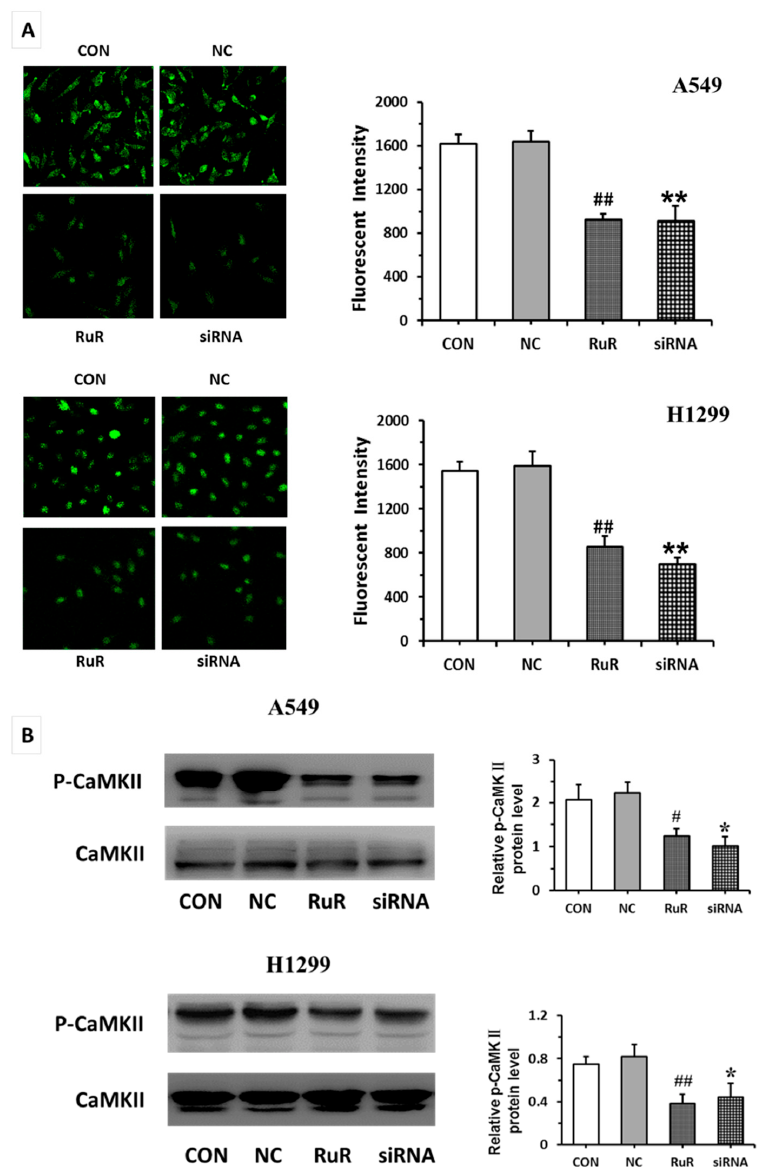
Figure 4. Measurement of [Ca 2+ ] i in A549 and H1299 cells. Fluorescent intensity in [Ca 2+ ] i was recorded by laser scanning confocal microscope in different treatments (400×) ( A ); Western blot assay for p-CaMKII expression in A549 and H1299 cells ( B ). All data were expressed as mean ± SD of triplicates. # p < 0.05 compared with control group; ## p < 0.01 compared with control group; * p < 0.05 compared with NC group; ** p < 0.01 compared with NC group.